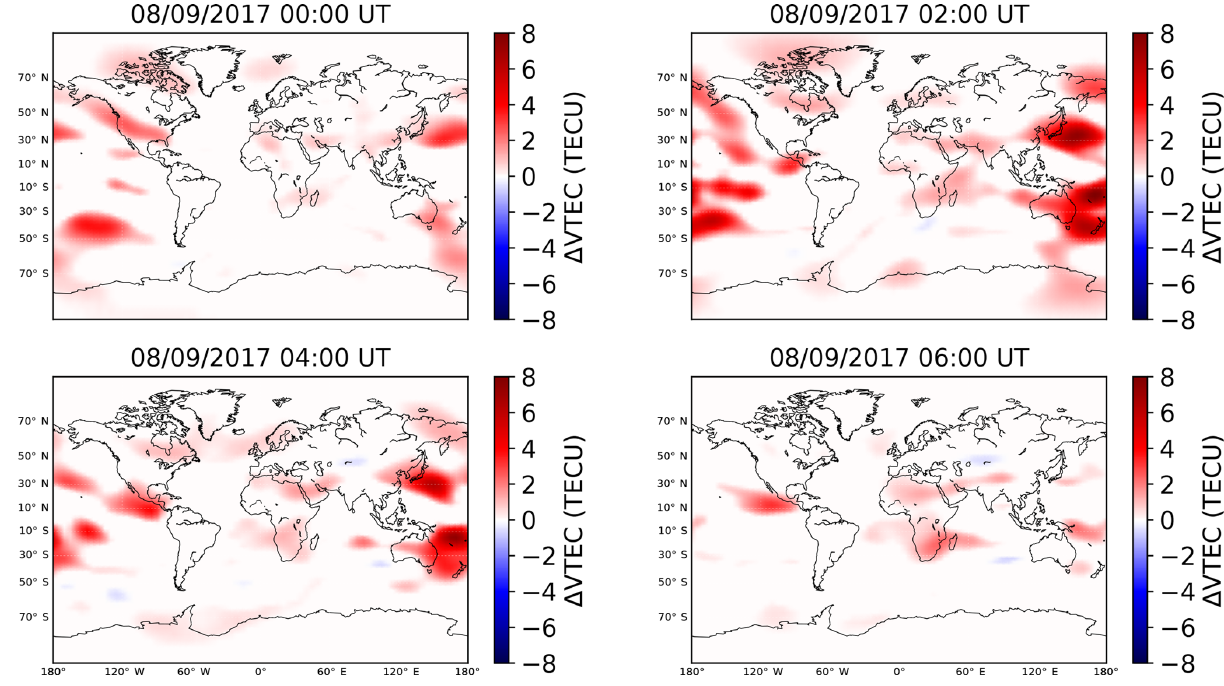
Figure 3. Differential VTEC maps for 8 September 2017 between 00:00 and 06:00UT.